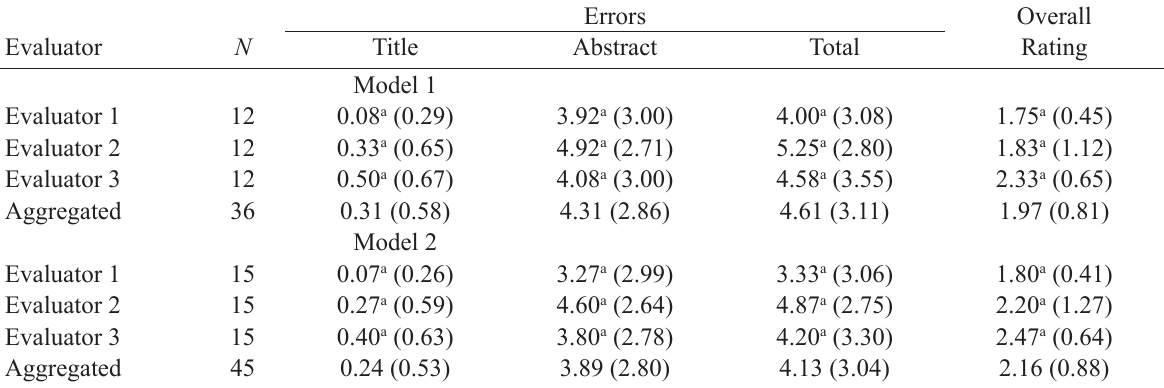
Mean (and Standard Deviation) for Error and Overall Rating Variables: Across Evaluators